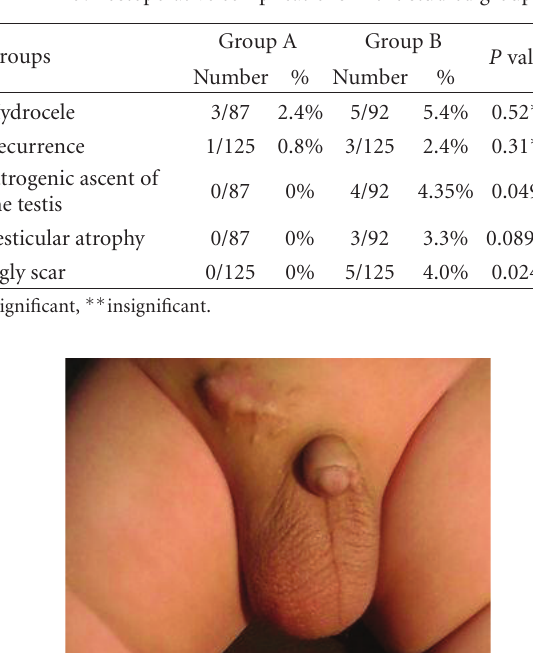
Table 3: Postoperative complications in the studied groups.